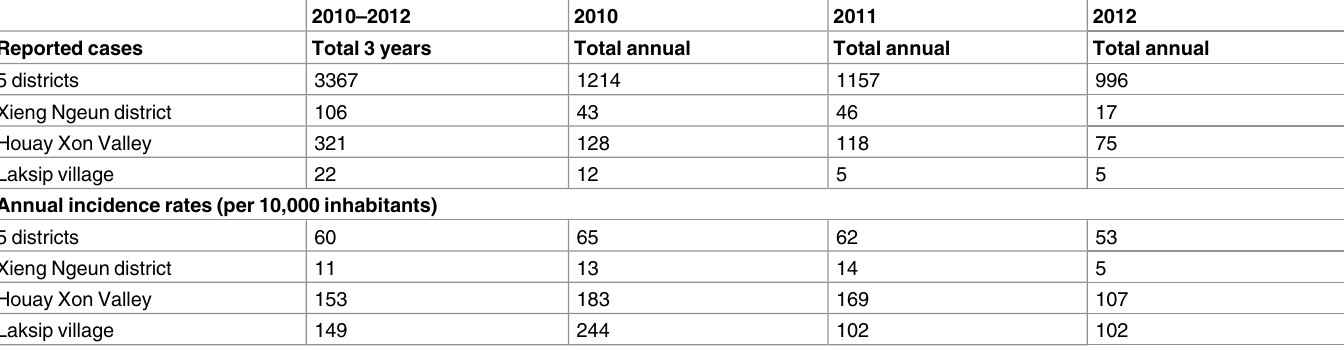
Table 2. Reported diarrheal disease cases (i.e., hospital admissions or incidence) and annual incidence rates (per 10,000inhabitants) from 2010 to 2012 across Luang Prabang area, Laos, and in the different spatial subsets. The incidencerate over the 2010–2012periodwas calculatedas the inter-annual averageincidenceover this